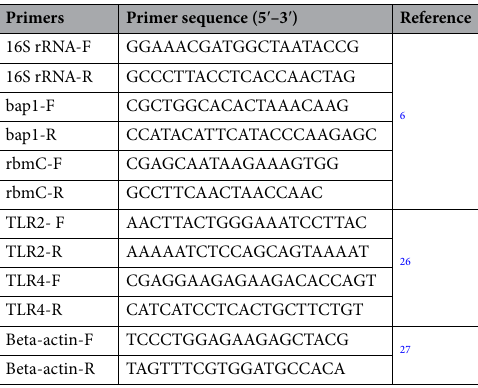
Table 1. Primers used in this study.